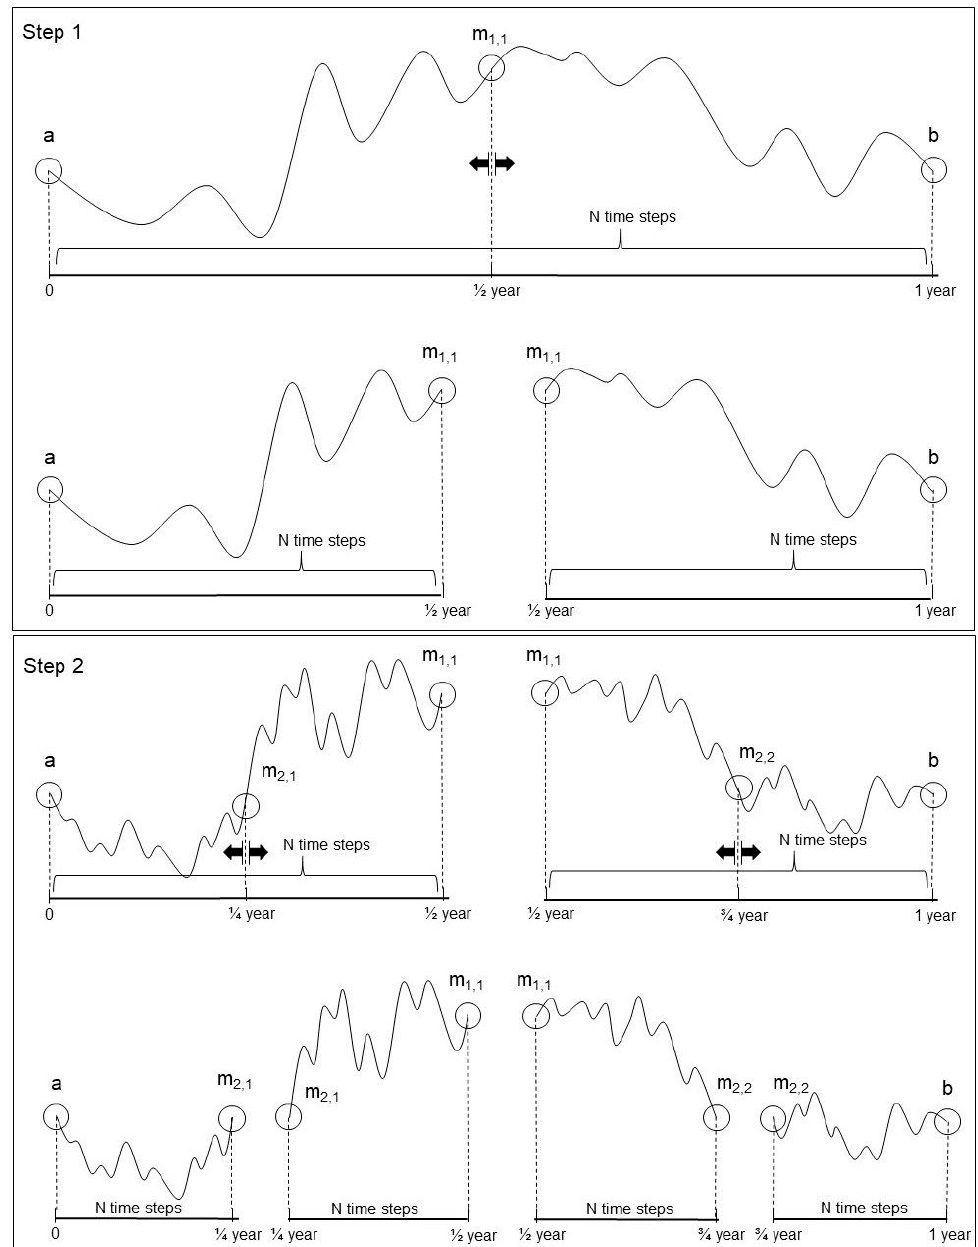
Figure 1. Graphical description of the first and second optimization step in the interval halving optimization method.